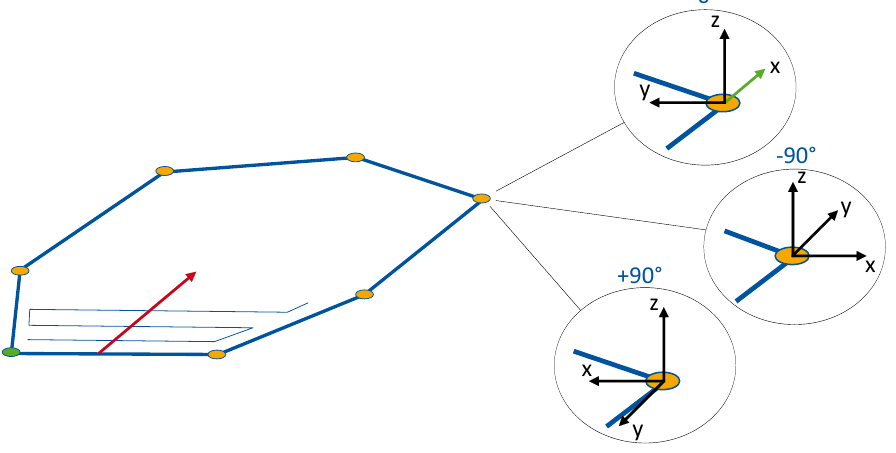
Figure 15. Inverse kinematics test-poses for a convex